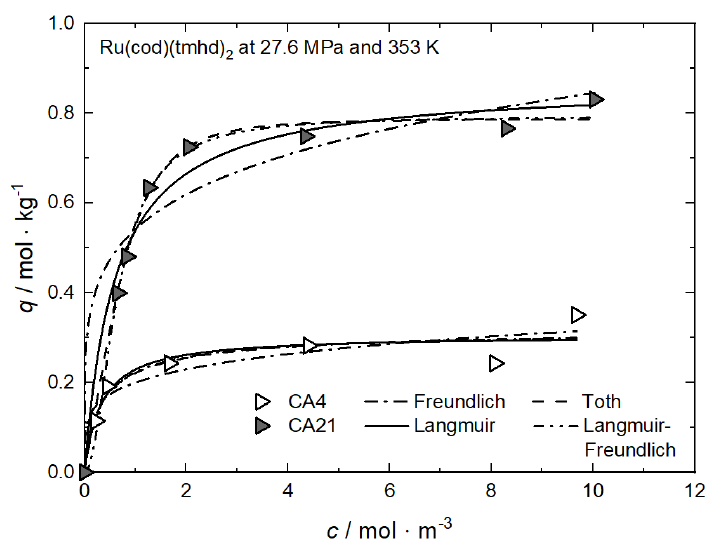
Figure 7. Uptake of Ru(cod)(tmhd) 2 at 27.6 MPa and 353 K on different substrates; experimental data taken from [53].